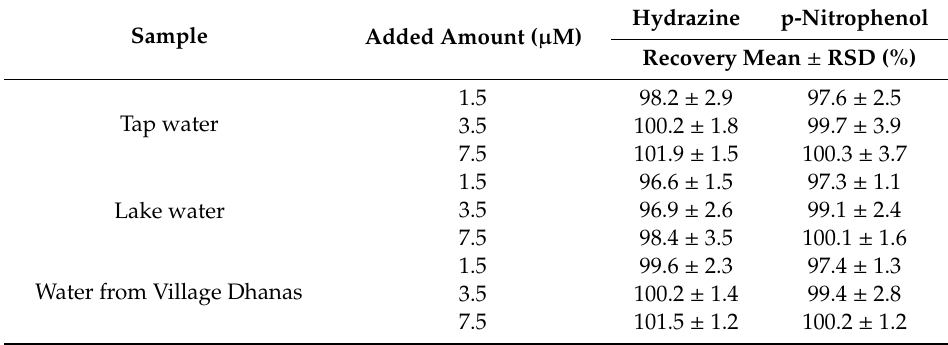
Table 2. Determinationofhydrazineandp-nitrophenolrealwatersamples. RSD:relativestandarddeviation.